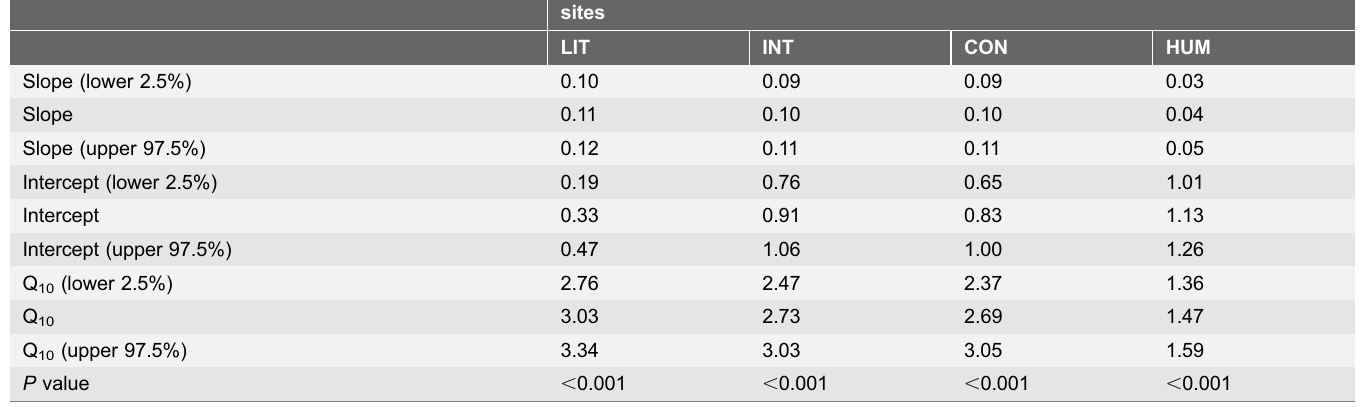
Table 2. Q 10 and estimated parameters simulating relationship between flux data and T 5